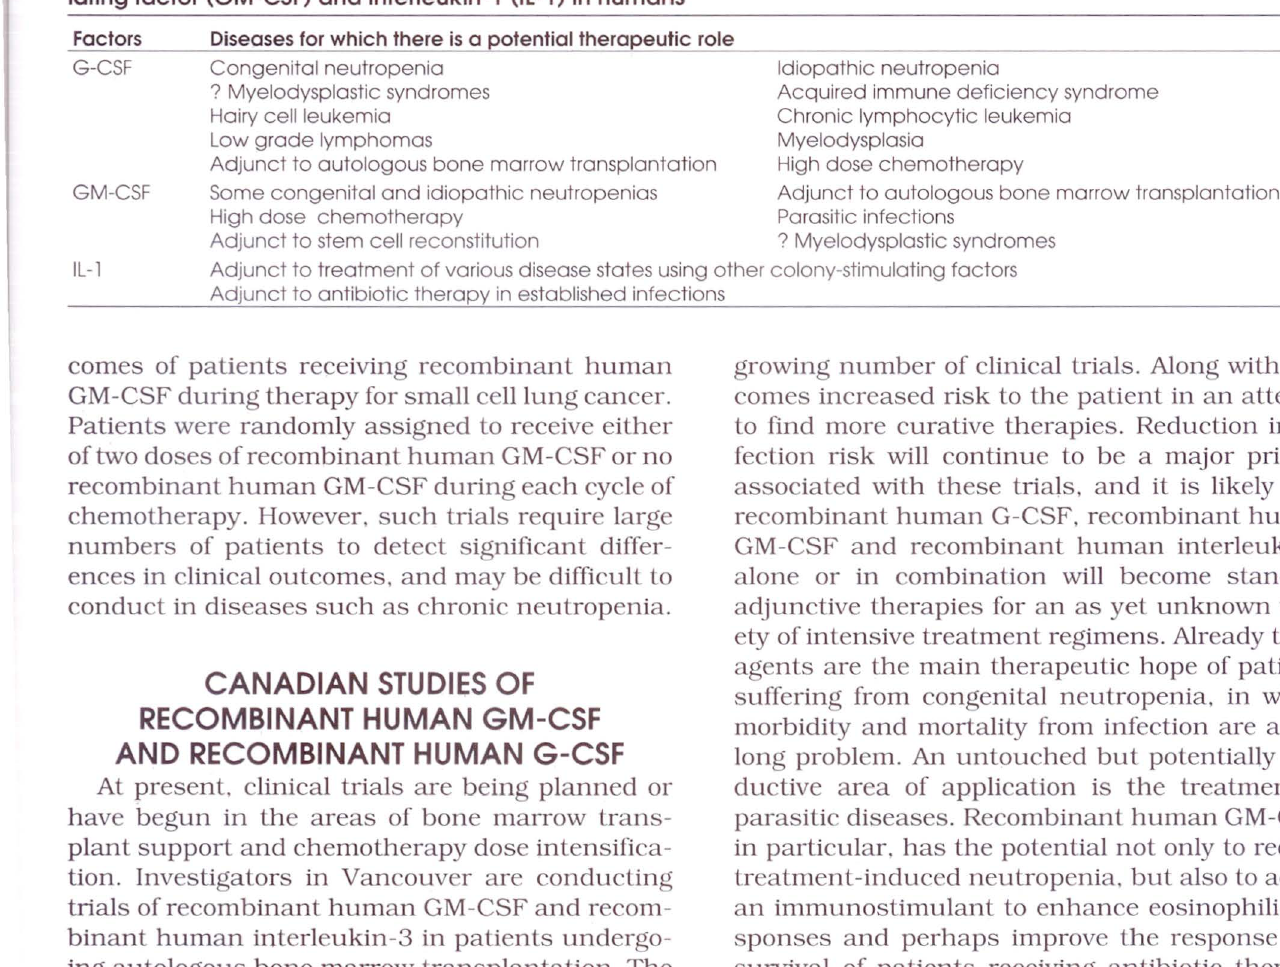
Potential therapeutic role of granulocyte colony-stimulating factor (G-CSF), granulocyte/macrophage colony-stimu lating factor (GM-CSF) and interleukin-1 (ll -1) in